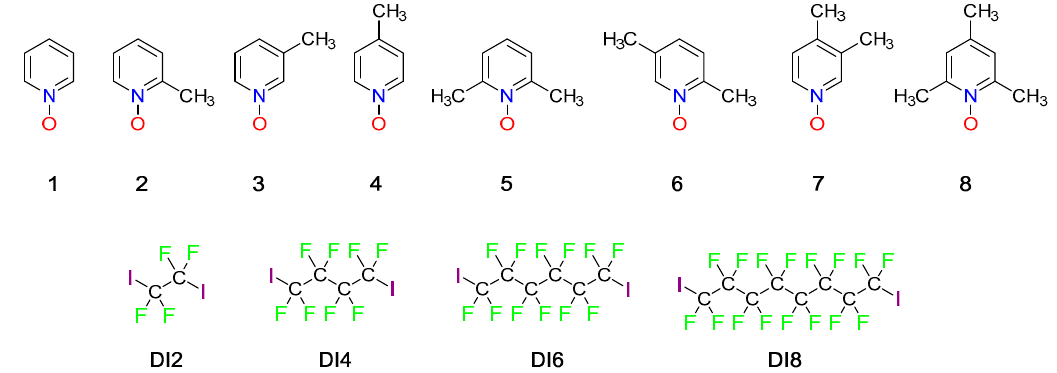
Figure 1. The chemical structures of acceptors (top) and donors (below) in the current study: